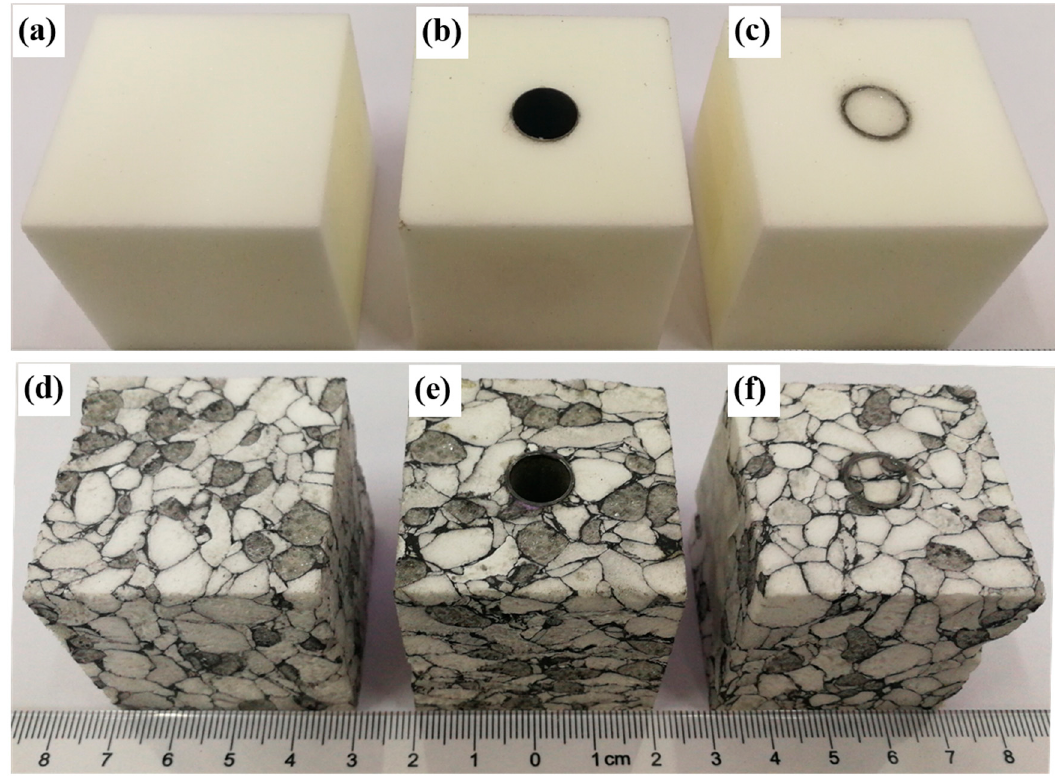
Figure 1. Specimen images of polymethacrylimide (PMI) foam. ( a ) PMI foam; ( b ) Tube-enhanced PMI foam; ( c ) Foam-filled tube-enhanced PMI foam; ( d ) Absorbent PMI foam; ( e ) Tube-enhanced absorbent PMI foam; ( f ) Foam-filled tube-enhanced absorbent PMI foam.